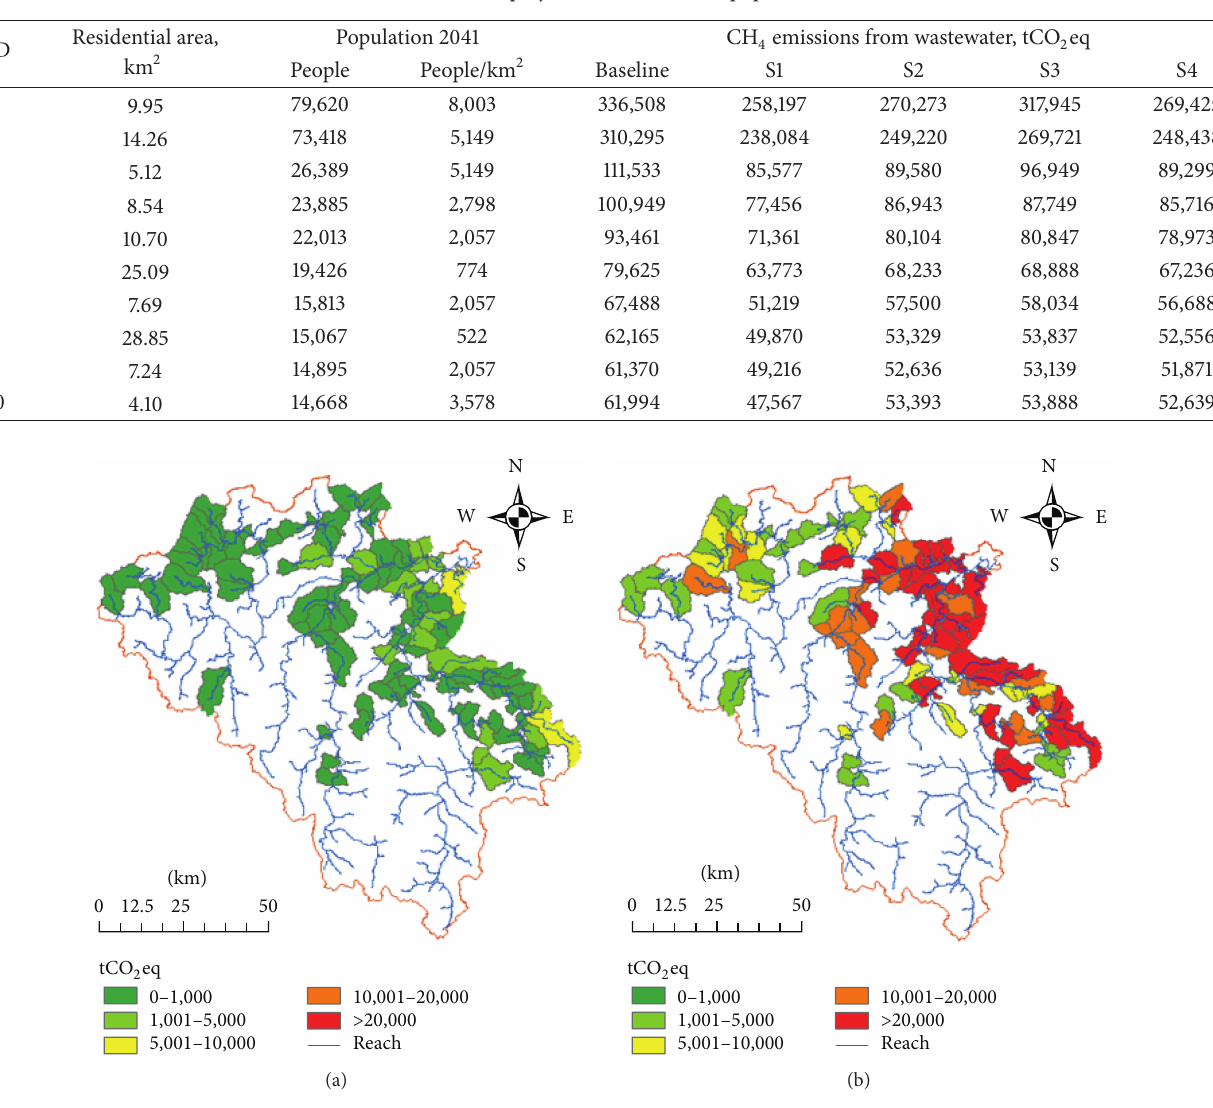
Figure 8: GHG emissions from domestic wastewater. (a) Inventory year 2012. (b) Baseline scenario for period of 30 years.